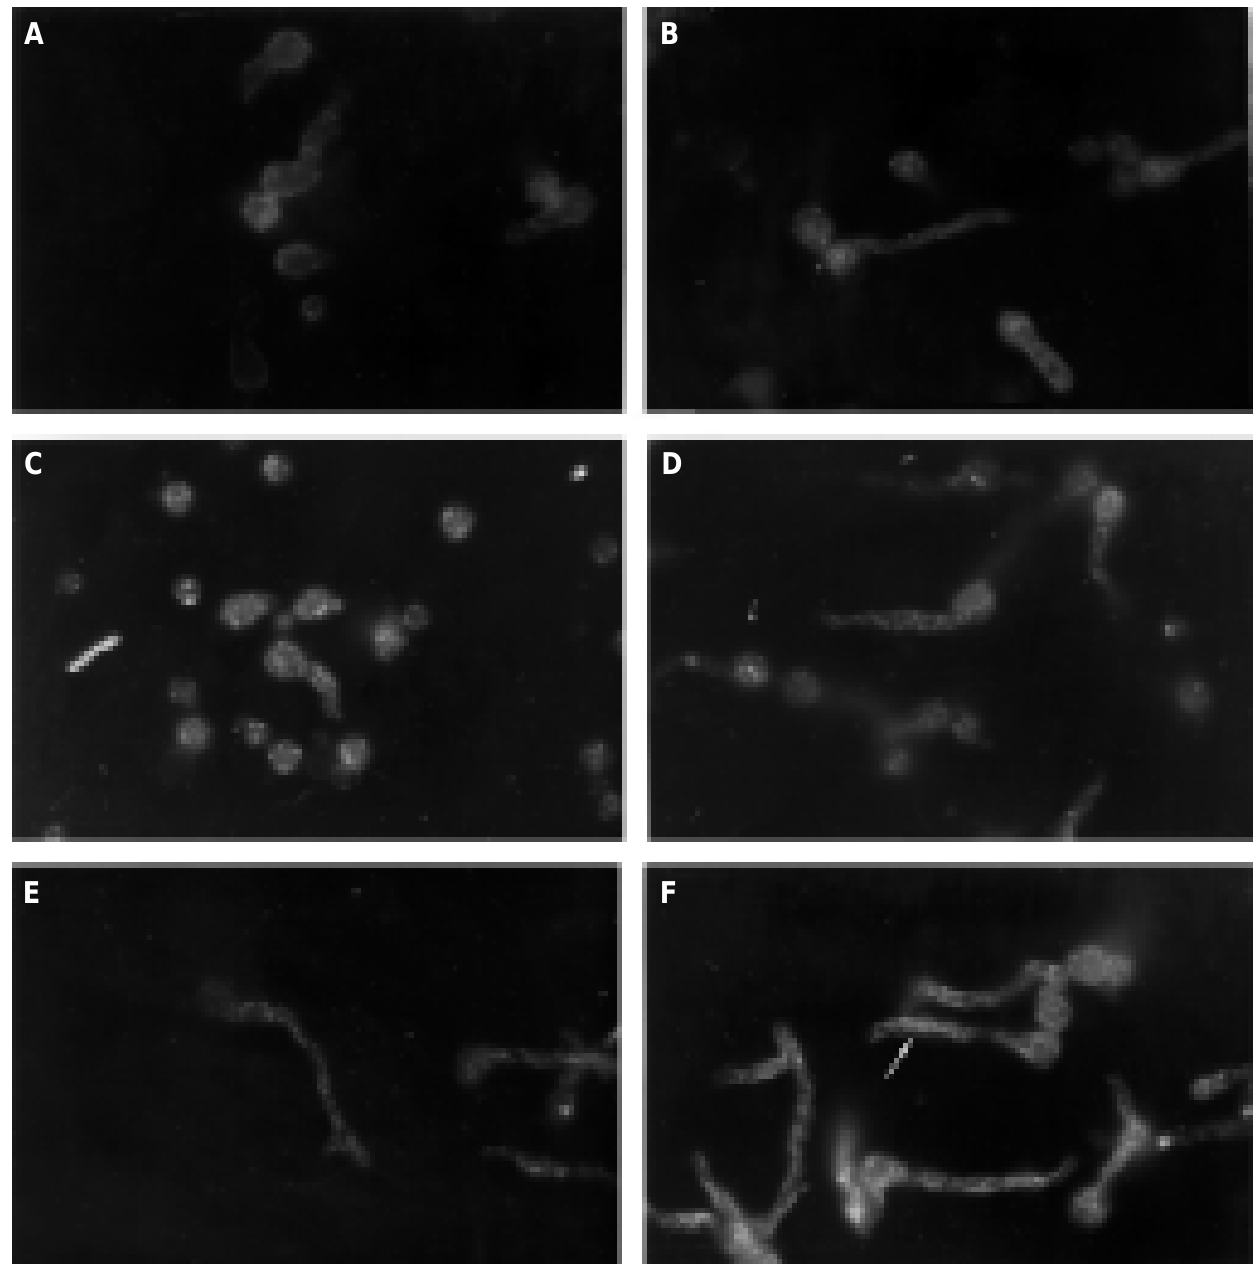
Figure 3 - Microtubule repolymerization of germlings of R21 strain of Aspergillus nidulans previously exposed to Benomyl for 90 min after transfer to Benomyl free-medium. Repolymerization was observed for different periods of time (B-F). A - Germlings without release from Benomyl. B-F - Microtubule (arrow) cytoskeleton repolymerization 10, 20, 30, 40 and 50 s, respectively, after Benomyl